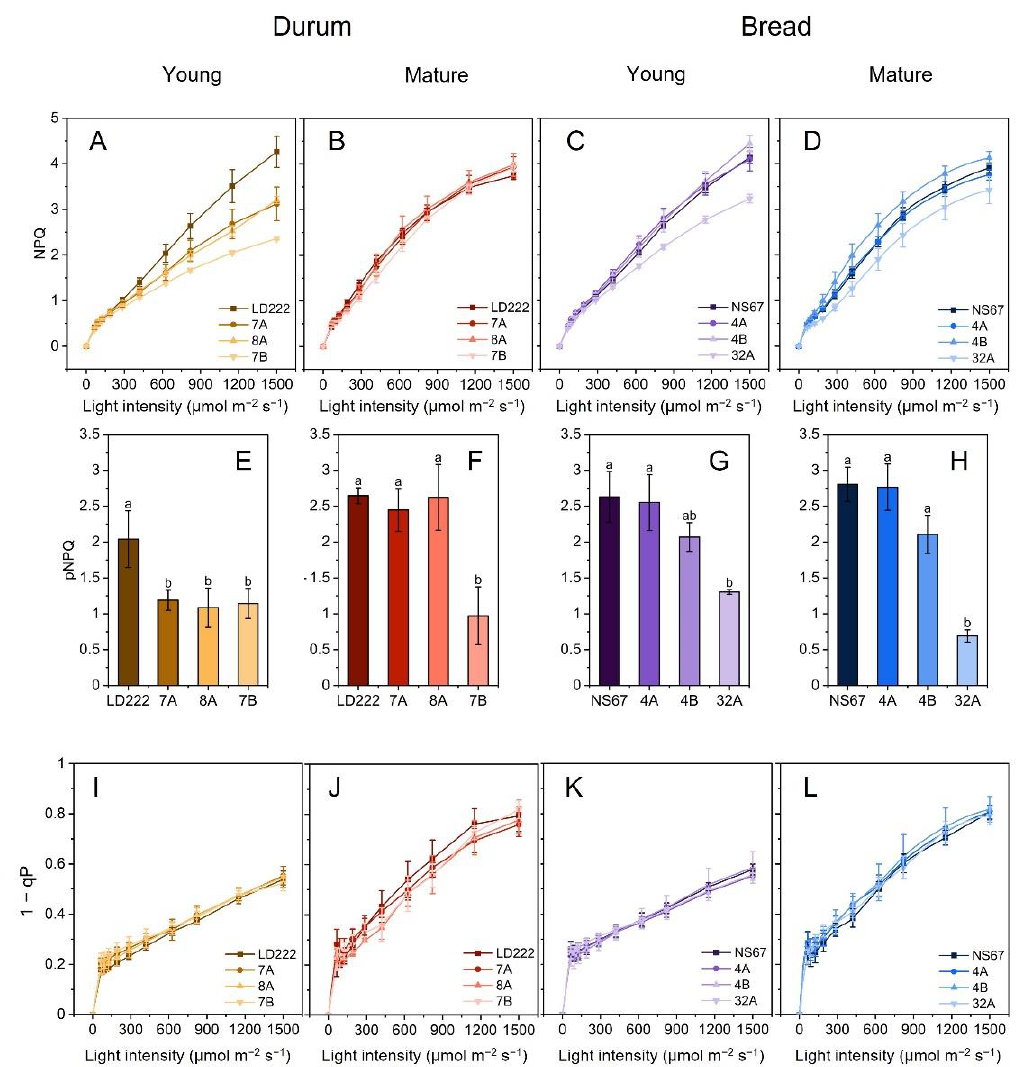
Figure 3. Fluorescence-quenching analysis in young and mature plants of bread and durum wheat. ( A – D ) NPQ-light-response curves of young durum ( A ), mature durum ( B ), young bread ( C ) and mature bread ( D ). ( E – H ) Photoprotective NPQ (pNPQ) values obtained after applying the “qP d method”. Histograms represent average values ± Standard Error for n = 4–6; different letters indicate a significant difference at p < 0.05, as determined using one-factor ANOVA followed by Tukey’s test. ( I – L ) Light-response curves of 1-qP of young-durum ( I ), mature-durum ( J ), young-bread ( K ) and mature-bread ( L ) plants. All light curves were obtained during 60 min exposure to increasing actinic-light intensities. Average values ± Standard Deviation for n = 4 – 6.